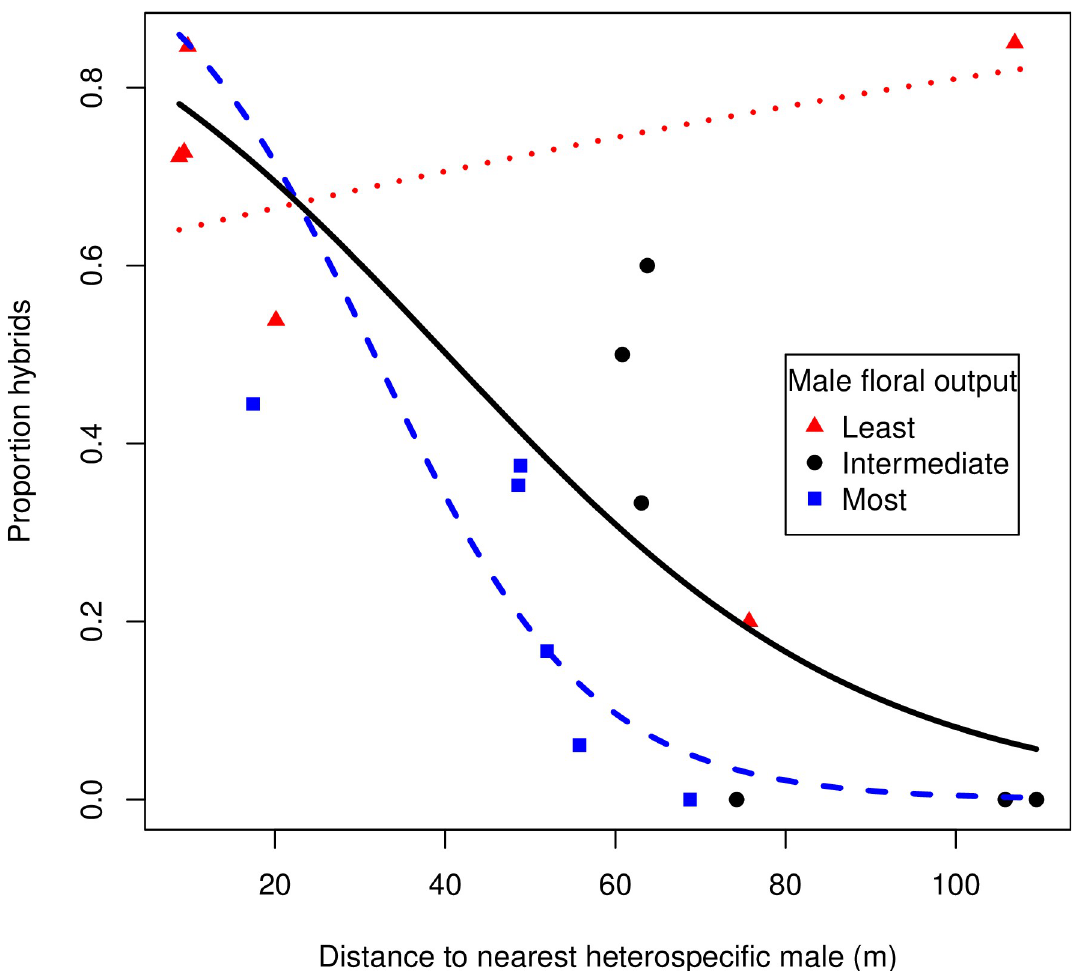
Fig 4. Hybridization rate and distance to the nearest heterospecific male in C . scandens . Data from open-pollinated pistillate plants. Each point represents the proportion hybrids from a single pistillate C . scandens (n = 18 pistillate plants, with 259 total seedlings). Red triangles represent the six pistillate individuals for which the nearest C . orbiculatus had the fewest flowers, blue squares represent the six pistillate individuals for which the nearest C . orbiculatus had the most flowers. Black circles are pistillate plants for which the nearest C . orbiculatus had an intermediate number of flowers. Curves represent the predicted values from the best performing GLM, and colors correspond to the points.